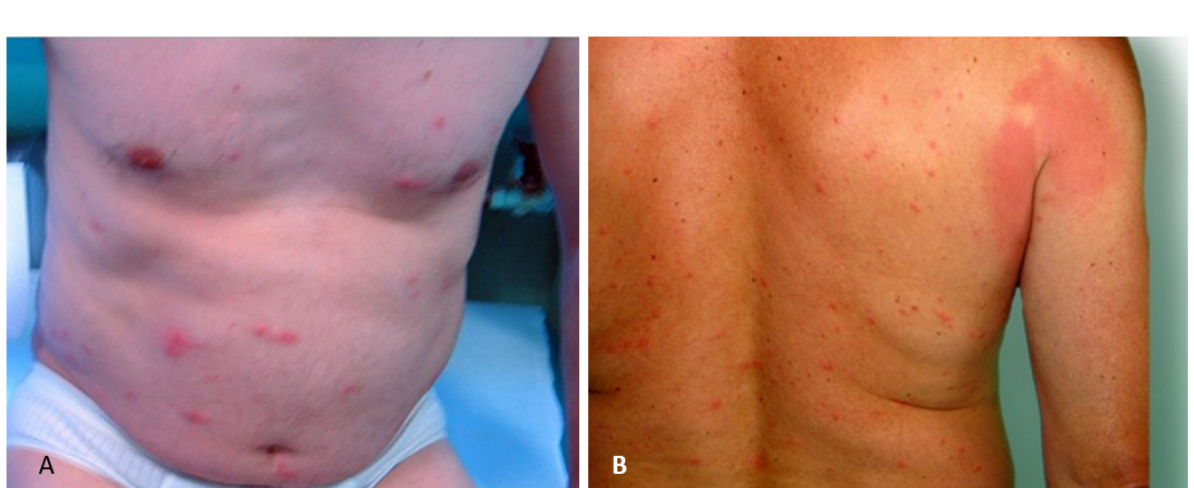
The patient had papules and blisters with serous secretions, erythema on the abdo-